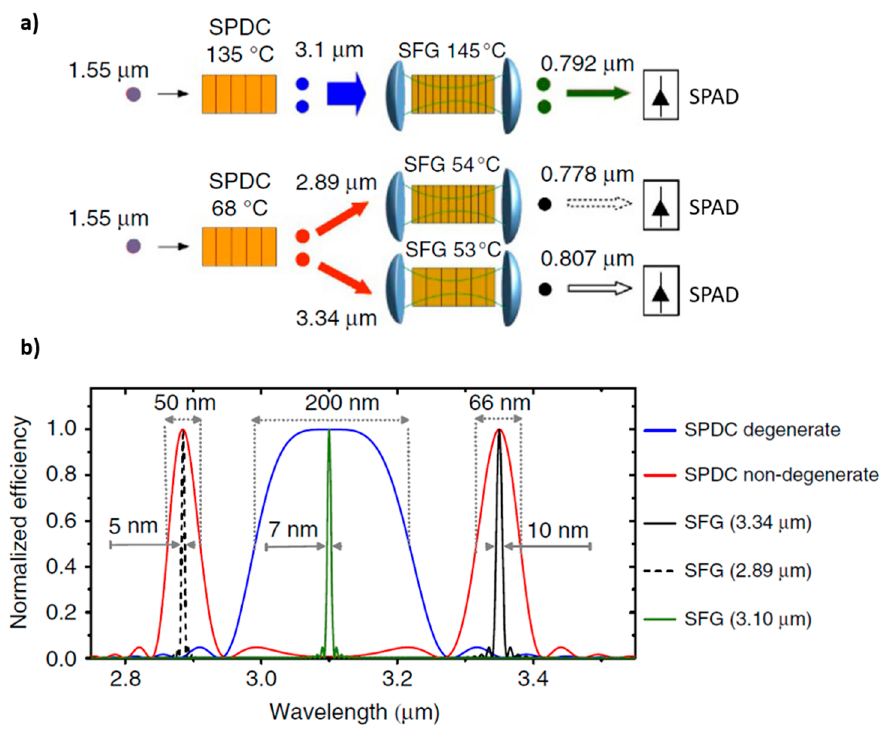
Figure 6. ( a ) Schemes of the generation and detection stages in the case of degenerate (top) and nondegenerate (bottom) SPDC and SFG processes; ( b ) simulated downconversion spectra and module bandwidth as a function of the temperature. The solid blue curve refers to the degenerate downconversion process around 3.1 mm, which was achieved at 135 °C. The solid red curve refers to the nondegenerate downconversion process, which was achieved at 68 °C. Adapted with permission from [71], copyright 2017.